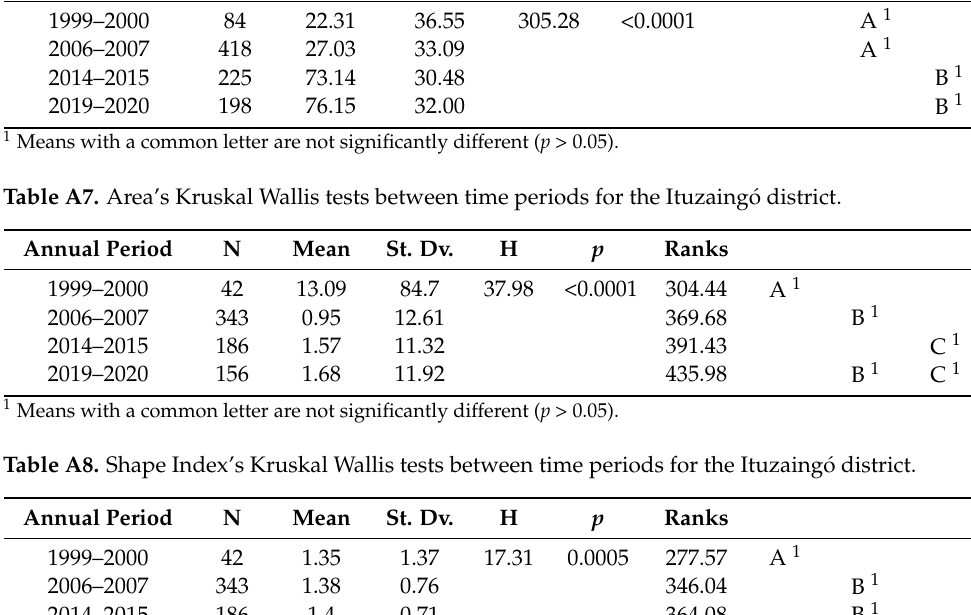
Table A6. Edge Contrast Index’s Kruskal Wallis tests between time periods. Annual Period N Mean St. Dv. p Ranks